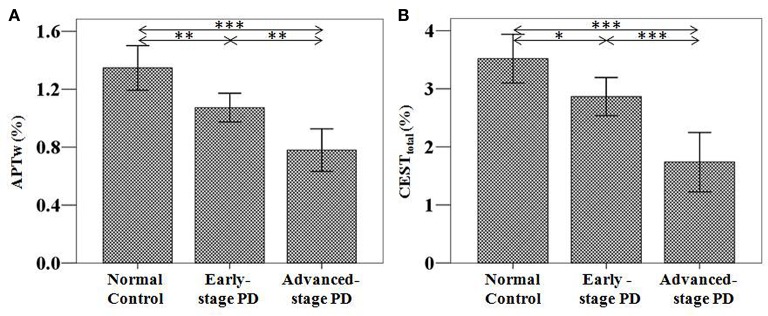
APTw (A) and CESTtotal
(B) values of the substantia nigra for normal controls (n = 24) and PD patients at different stages (grouped by the H&Y scale) (n = 38 for early-stage and n = 23 for advanced-stage). The APTw and CESTtotal values of the substantia nigra for normal controls, early-stage, and advanced-stage PD patients were (1.35 ± 0.15) and (3.52 ± 0.42)%, (1.07 ± 0.10) and (2.87 ± 0.34)%, (0.78 ± 0.15) and (1.74 ± 0.52)%, respectively. Both showed a gradual decrease with disease progression. *P < 0.05; **P < 0.01; ***P < 0.001.